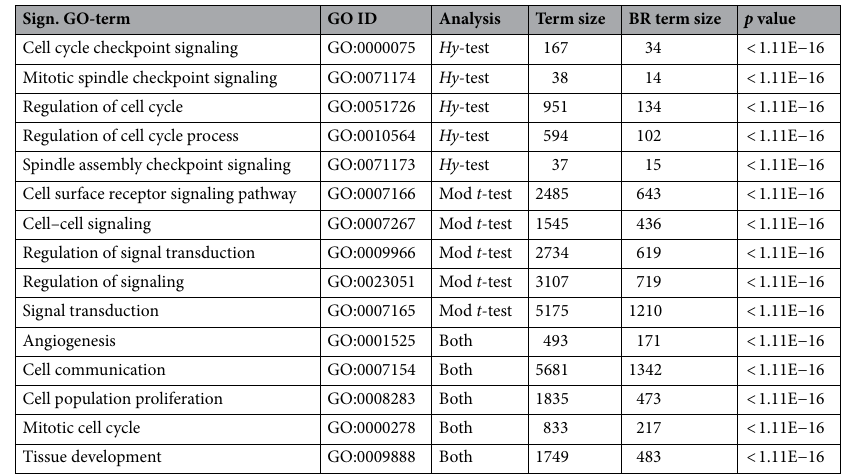
Table 1. GO-terms significantly associated with breast cancer among significant GO-terms found using Hy-test, moderated t-test and both procedures. Term size is the number of genes that compose a GO-term; BR term size is the number of GO-term genes associated with breast cancer; p-value is computed by using the hypergeometric distribution.